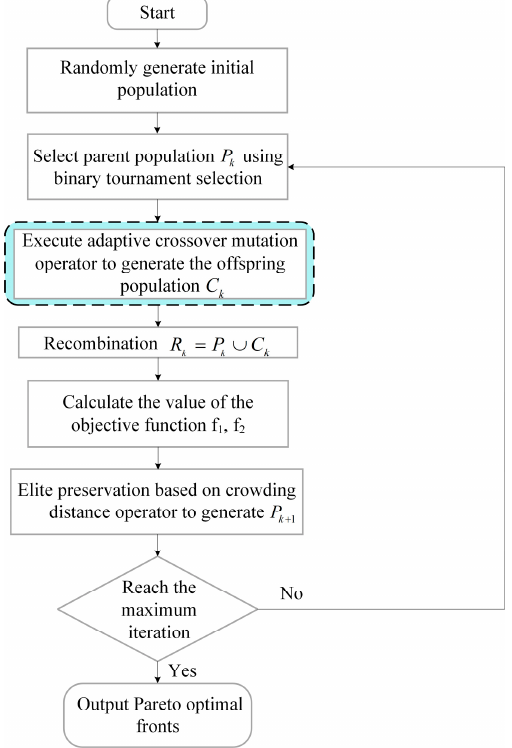
Figure 4. The flowchart of the proposed IMNSGA-II.